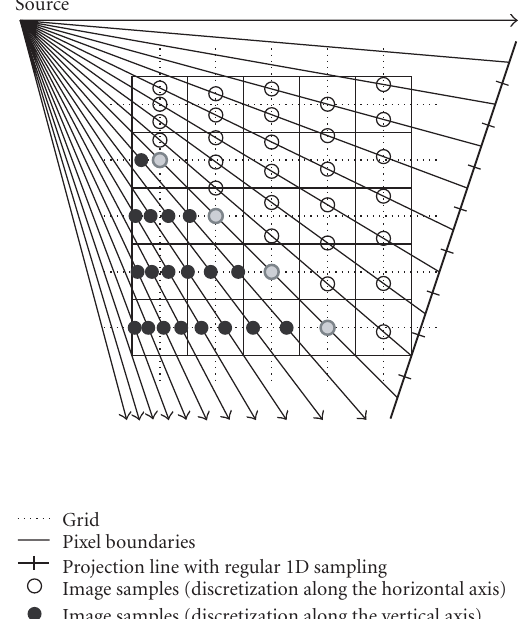
Projection line with regular 1D sampling Image samples (discretization along the horizontal axis) Image samples (discretization along the vertical axis) Figure 4: Shearing approach to perform the cone-beam projection of a 2D image onto a 1D